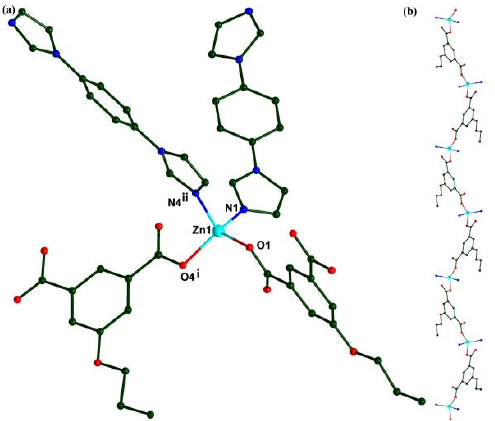
Figure 1. ( a ) The coordination environment of Zn(II) ions in complex 1 . ( b ) View of the 1D zigzag chain of complex 1 . Symmetry codes: i = x + 1/2, − y + 1/2,z + 1/2; ii = − x + 5/2,y − 1/2, − z + 3/2. Color codes: Zn, turquiose; O, red; C, dark green; N, blue.